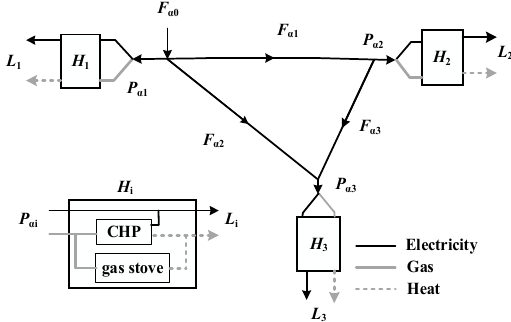
9 of 21 Table 1. Solving steps of optimal scheduling based on game theory for multi-energy hub system. 1: Give relevant parameters of multi-energy hub system